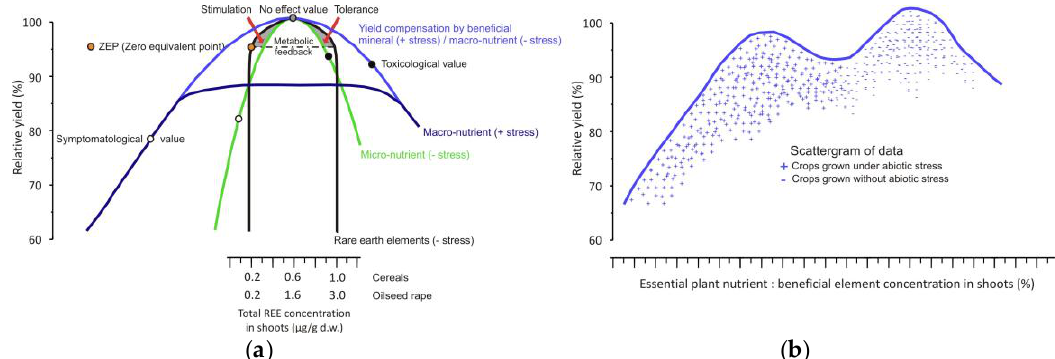
Figure 2. Common, abstract upper boundary line progression for essential macro- and micronutrients and beneficial minerals in relation to abiotic stress, and predicted progression of upper boundary lines for rare earth elements (REEs) ( a ); scattergram showing the relationship between essential plant nutrients and beneficial elements on crop yield indicating two categories (+/ − ) of the discriminating variable abiotic stress ( b ) (adapted from [20]).